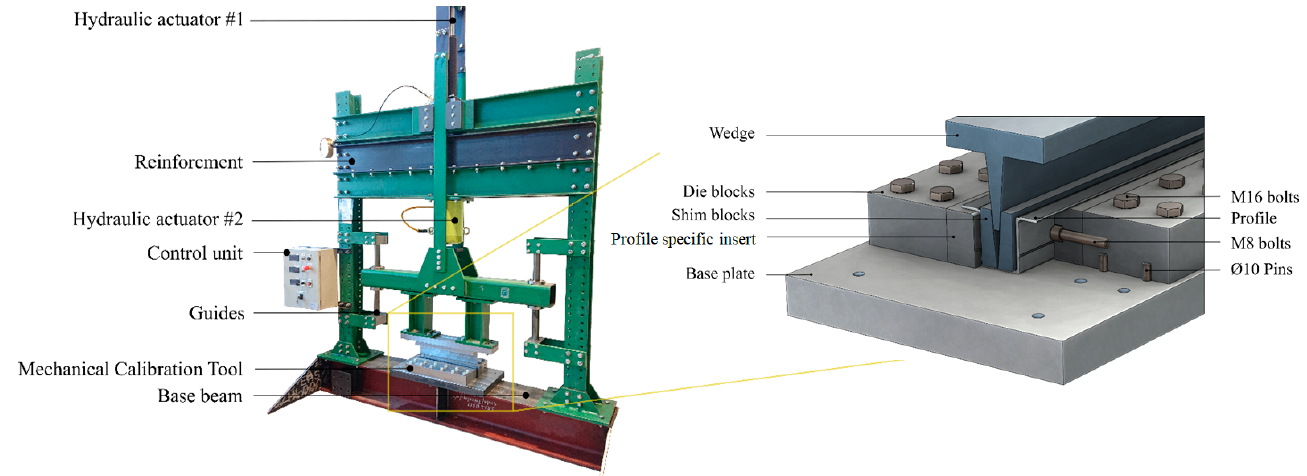
Figure 2. Stretch bending and local calibration experimental setup (redrawn from